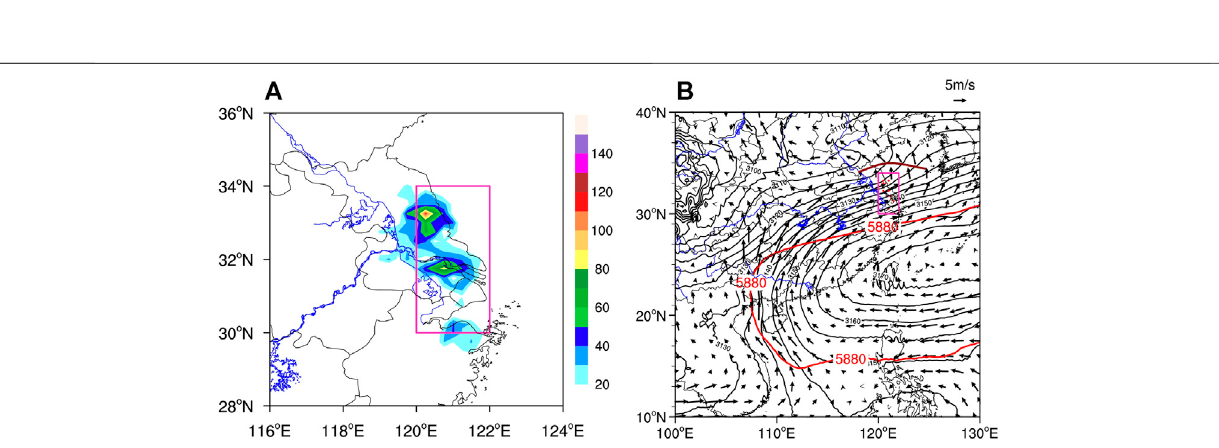
Location of the CRA